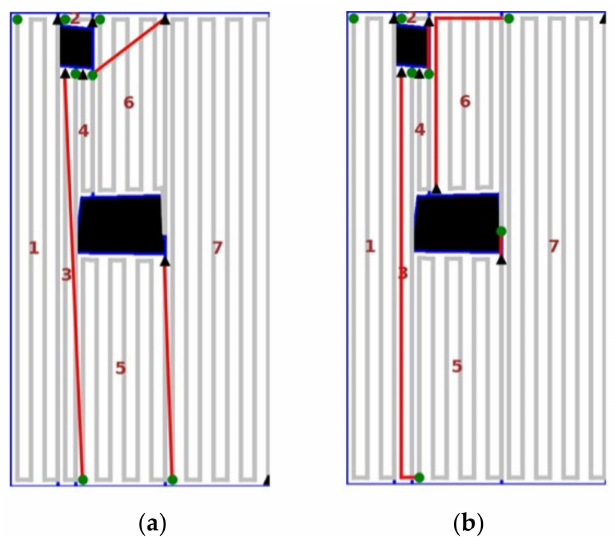
Figure 14. ( a ) Traditional CCPP; ( b ) improved CCPP. In the figure, the green dots represent the starting point of each sub-region and the black triangle represents the finishing point of each region. The red lines are the route connecting